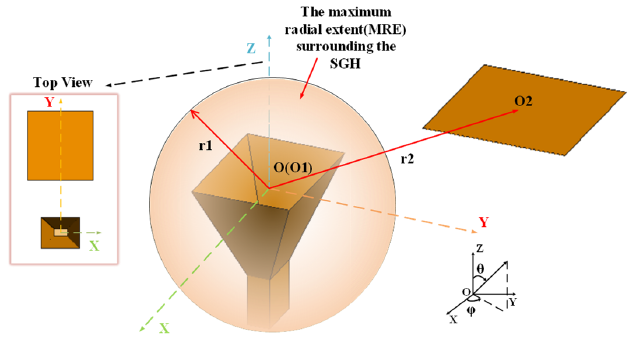
Figure 1. Antenna model with the metal plate.